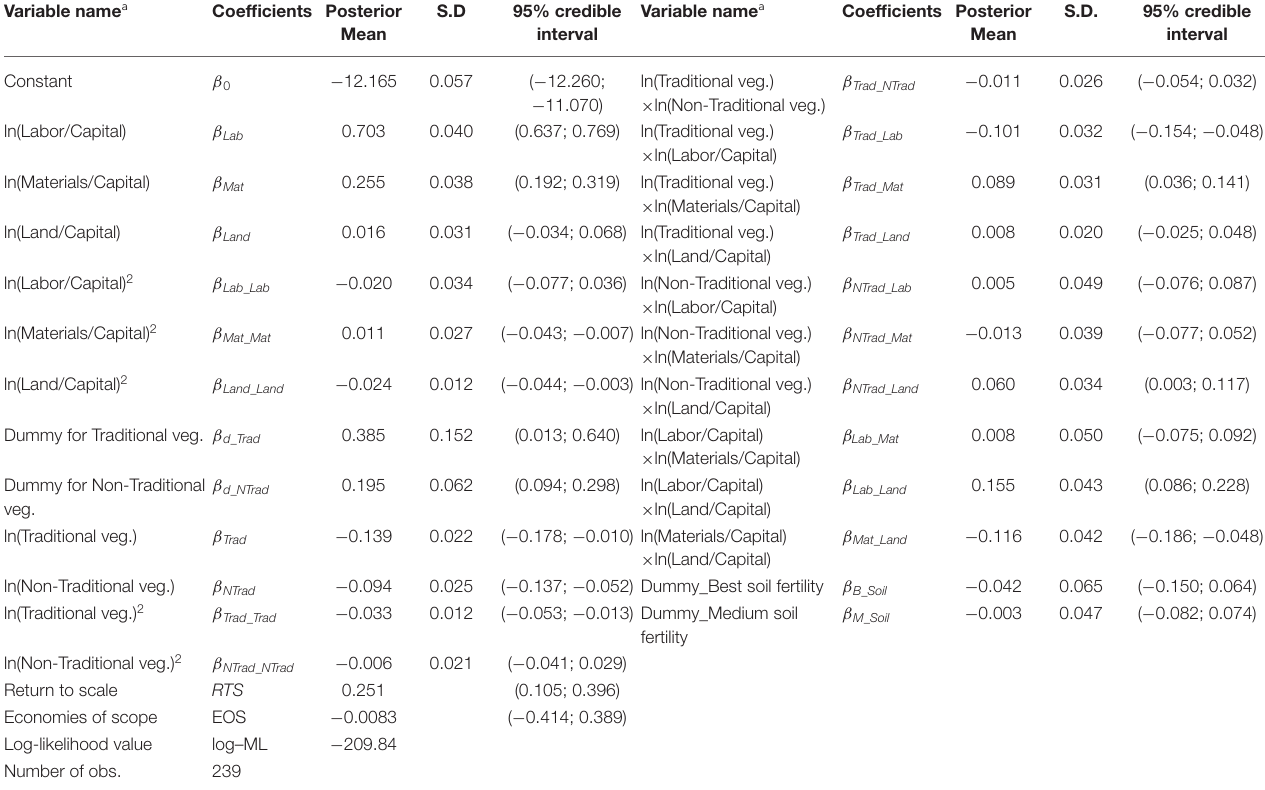
TABLE 2 | Bayesian MCMC estimates of the Translog input distance function